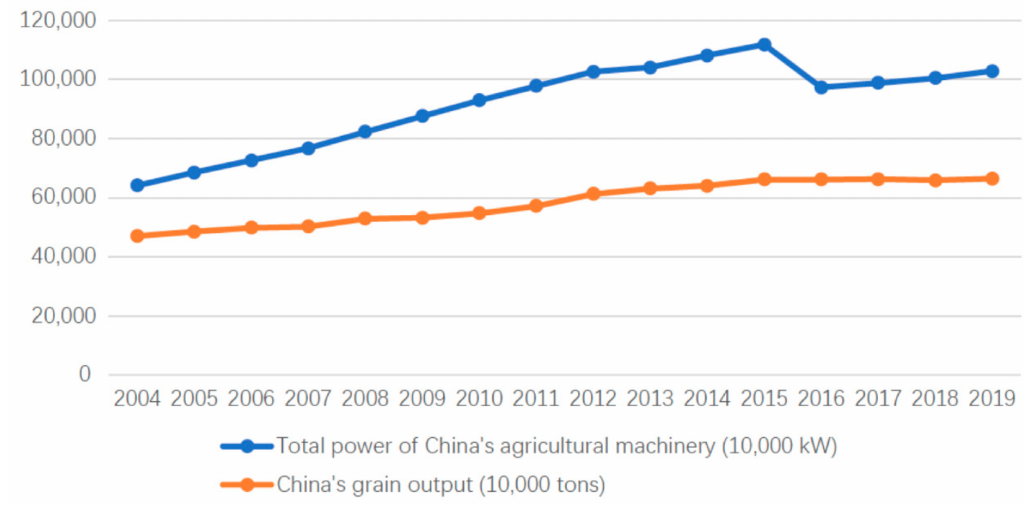
Figure A1. Graph of relationship between the total power of China’s agricultural machinery and China’s grain